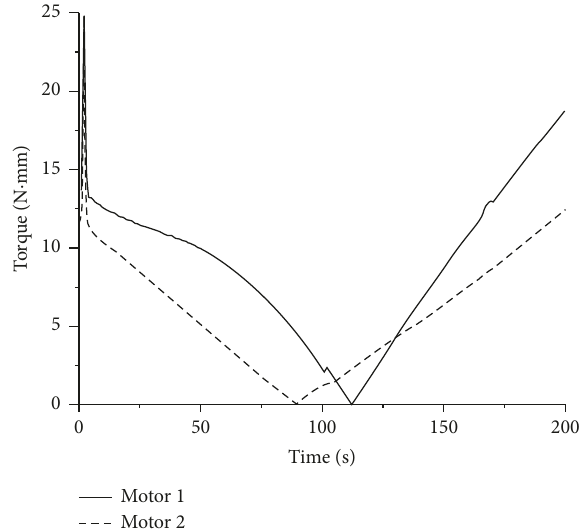
Figure 17: Dynamic curves of driving torques of the two motors.